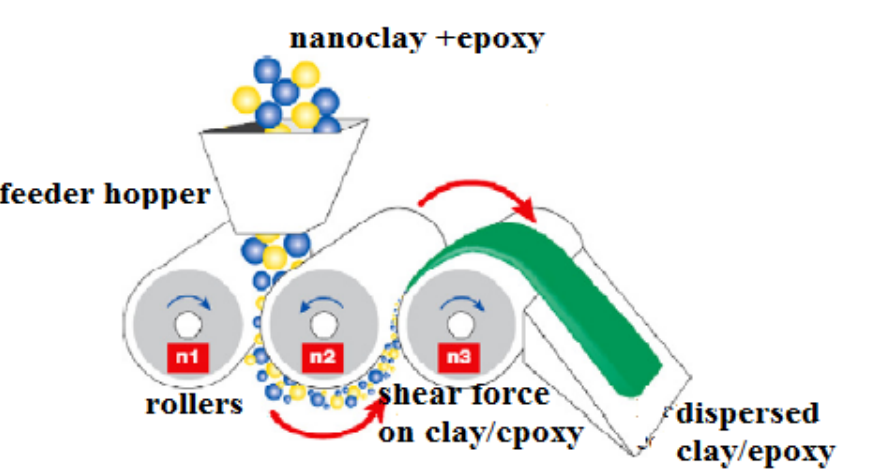
Figure 5. Three roll Milling process